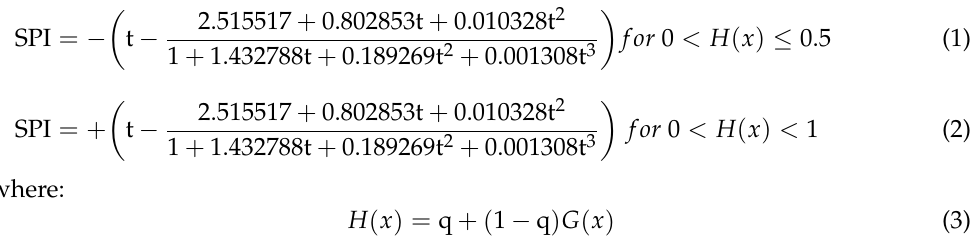
between 1990 and 2019 (left graph); ( b ) production in tons across Hungary (middle graph); and ( c ) sunflower yield between Figure 2. Evolution of sunflower cultivation across Hungary at a national scale (1990–2019): ( a ) harvested sunflower land